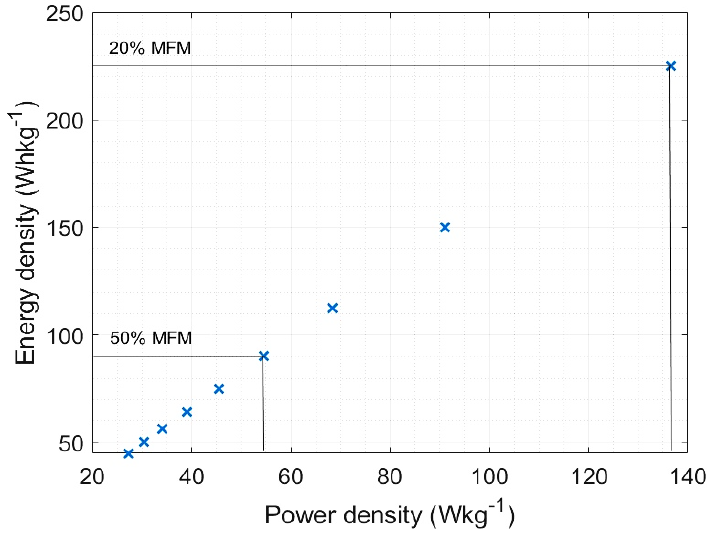
Figure 10. Gravimetric energy and power density requirements for an MEA SPC airframe. The marks show the percentages of the airframe mass replaced by multifunctional material (MFM) in increments of 10%.